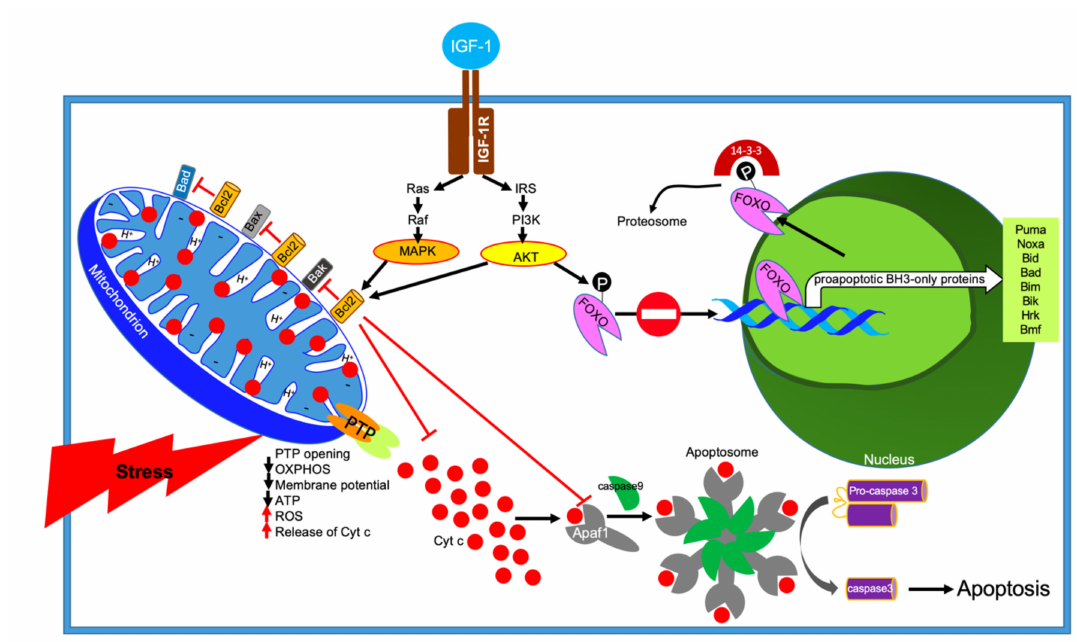
Figure 6. The e ff ects of IGF-1 on mitochondria-mediated apoptosis: Cellular stress leads to permeability transitionpore(PTP)opening, reductioninOXPHOSfunction, membranepotential,